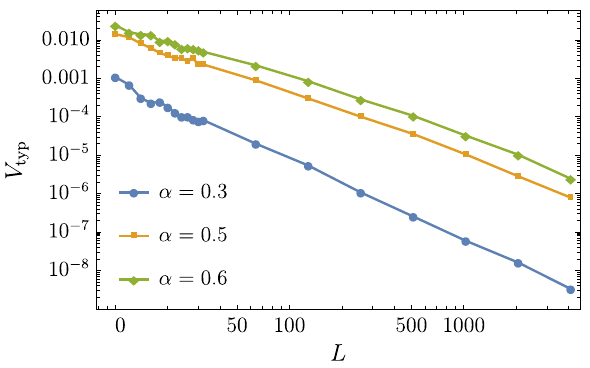
FIG. 15. Characteristic energy scale for typical resonances, as a function of the system size, shown for different disorder